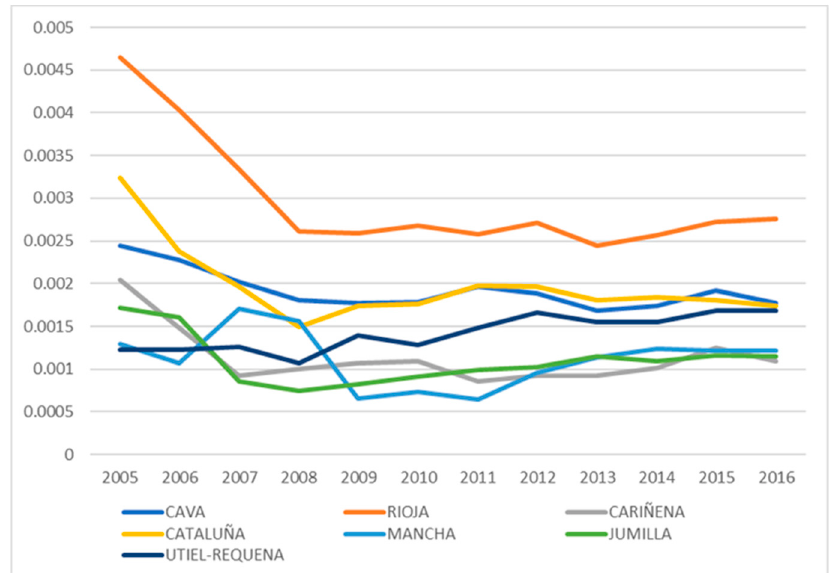
Figure 1. Evolution of CO 2 emissions per exported litre of wine for the main Spanish DOs.